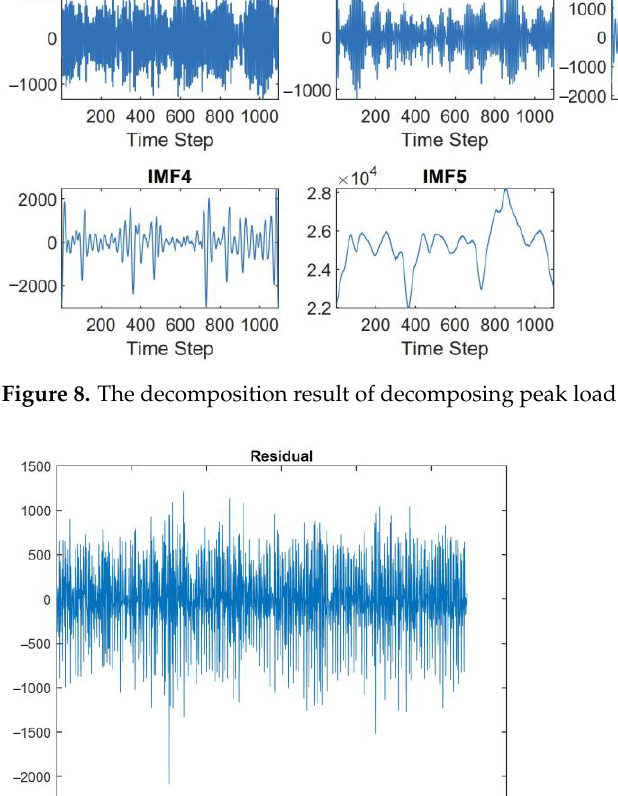
Figure 9. The decomposition result of decomposing peak load into residuals.